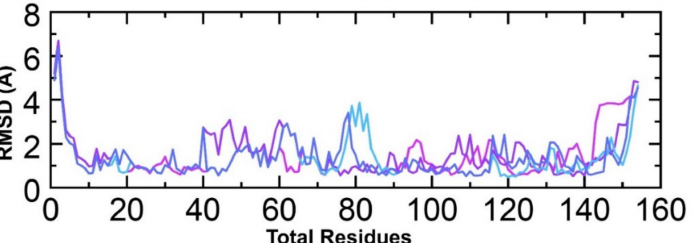
Figure 6. Root mean square fluctuation of all hits. The regions between 40 and 80 and then 105 and 140 particularly exhibit variations in the fluctuations. The region of 105–140 is the ligand binding site, thus implying that the binding of the ligands produces different conformational